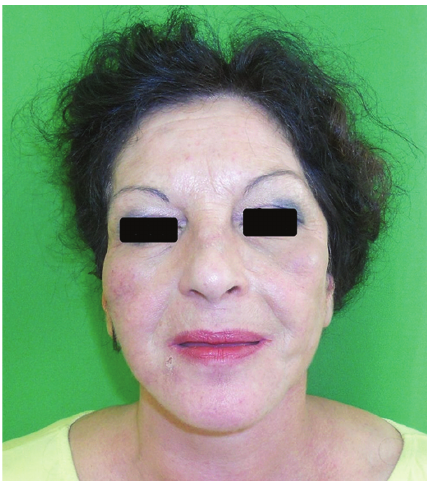
Figure 2: Final result after three lipofilling procedures at 12-month